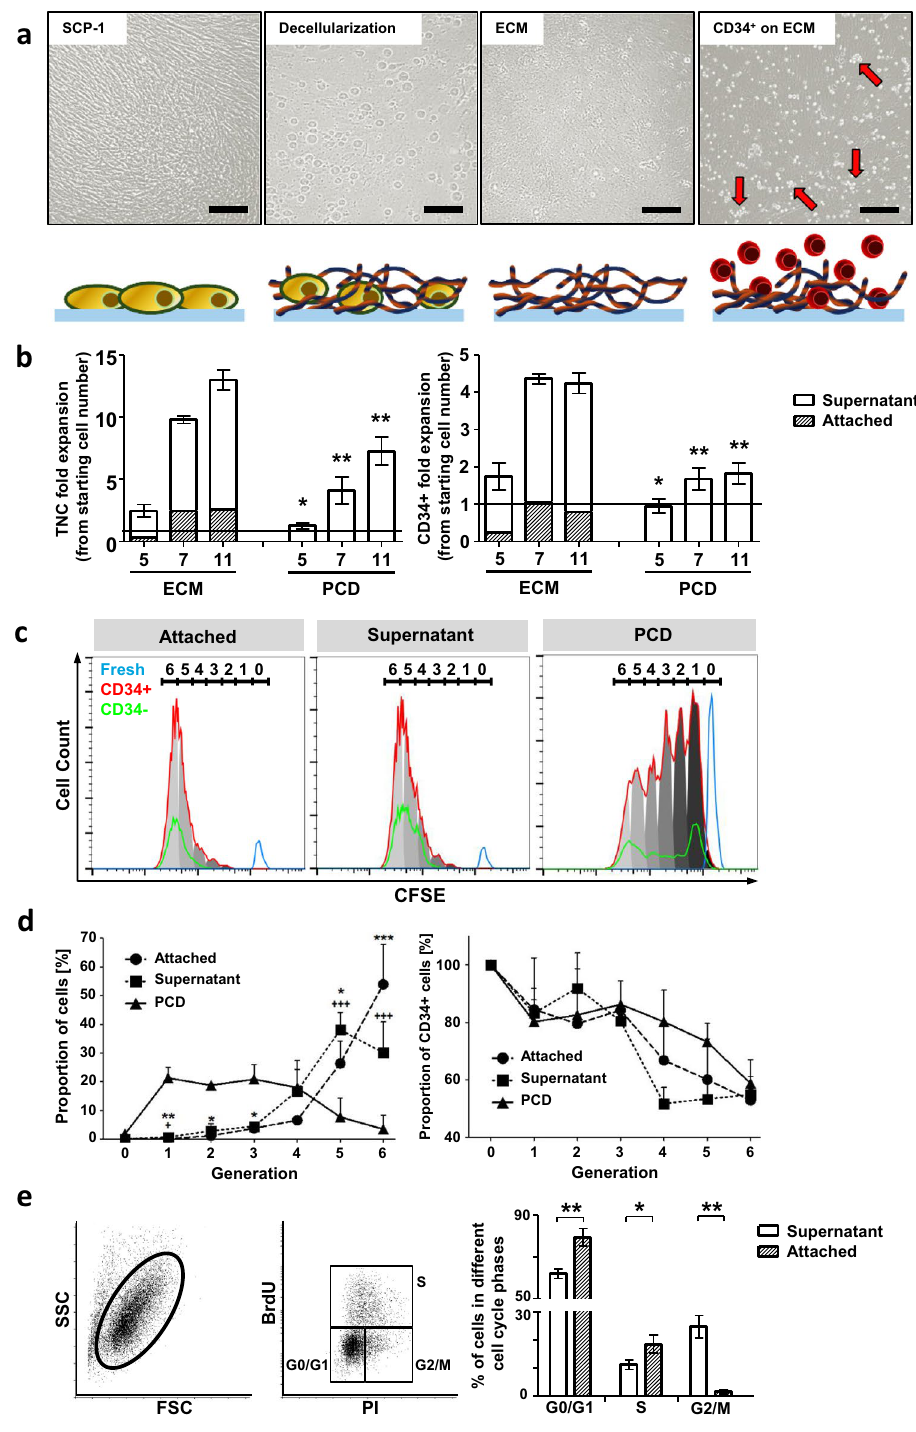
Figure 1. ECM scaffolds support CD34 + cell expansion in vitro . ( a ) Phase contrast images and corresponding cartoons of decellularization process for ECM scaffold generation. After 5 days in ECM-culture cells showed clustered accumulation (red arrows) ( b ) In vitro TNC and CD34 + cell expansion either on ECM or PCD culture for 5, 7 and 11 days. Fold change in relation to starting cell number. AT-cells are presented as proportion of ECM cultured cells. n = 5, two-tailed t-test, significance in comparison to ECM ( c ) Representative CFSE- intensity histogram after 5 days in ECM or PCD culture representing distribution of cell generations of CD34 + (red) and CD34 - (green) cells. Fresh cells (blue) as control (generation 0). ( d ) Proportion of 5 days ECM and PCD cultured cells (left) or CD34 + (right) cells in cell generations. n = 3, two-tailed t-test; * = AT-cell and + = SN-cell significance in comparison to PCD. ( e ) Representative flow cytometry dot-plots for BrdU- and PI-staining (left panel). Quantification of cell cycle phases of SN- and AT-cells after 5 days ECM culture (right panel). n = 3, two-tailed t-test. Error bars, s.e.m.; * p < 0.05, ** p < 0.01, *** p <